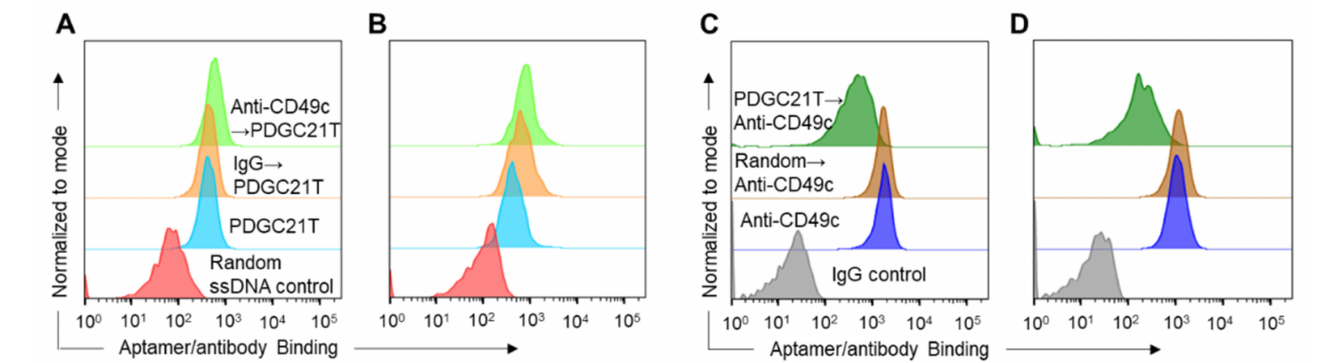
Figure 6. PDGC21T aptamer and anti-CD49c share an overlapping binding site on CD49c. Pre- treatment with anti-CD49c did not affect FAM-labeled PDGC21T aptamer binding to MDA-MB-231 ( A ) or HCC38 cells ( B ). IgG isotype and a random ssDNA were used as controls. Pre-treatment with PDGC21T aptamer inhibited PE-labeled anti-CD49c binding to MDA-MB-231 ( C ) and HCC38 cells ( D ). Arrows indicate incubation sequence of antibodies and